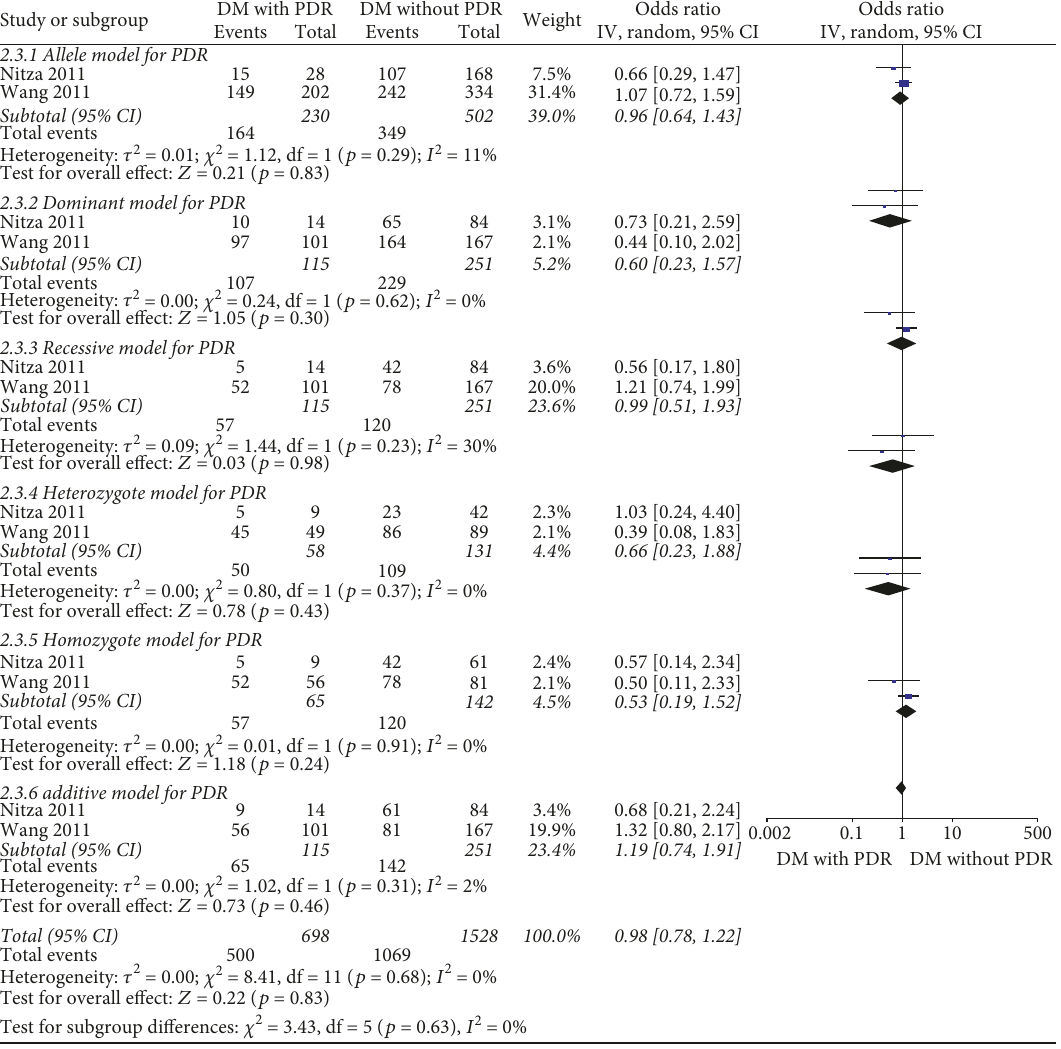
Figure 9: Forest plot for meta analysis comparing PDR with DWR in di ff erent